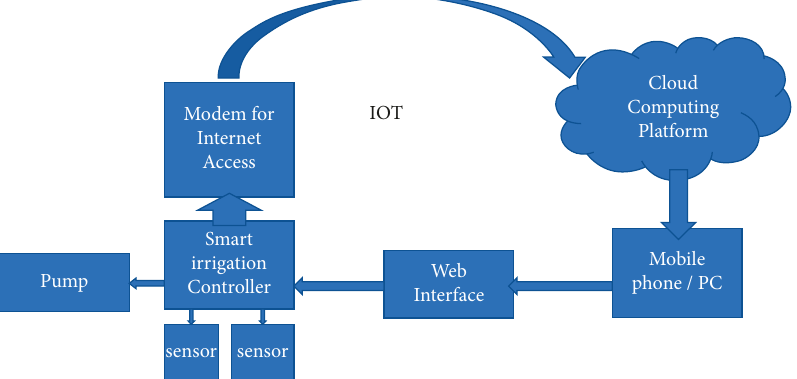
Figure 1: IoT architecture designed for this study.